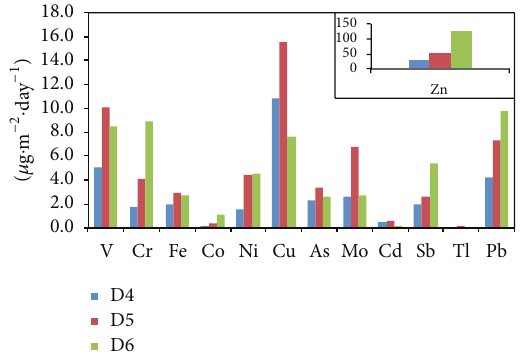
Figure 12: Score plot of the two first principal components obtained by PCA analysis of fluxes determined in D4.